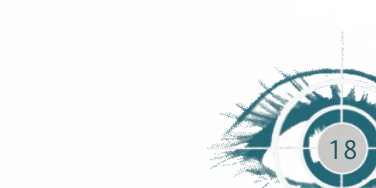
Figure 5. Trajectories of short-term or temporal variation for samples of 40 measurements of AACD (mm) for 10 young subjects are indicated. The individual measurements for subjects (S1 to S10) are connected using 10 trajectories of different colours and markers. See Table 2 for the means, standard deviations, minima and maxima for these